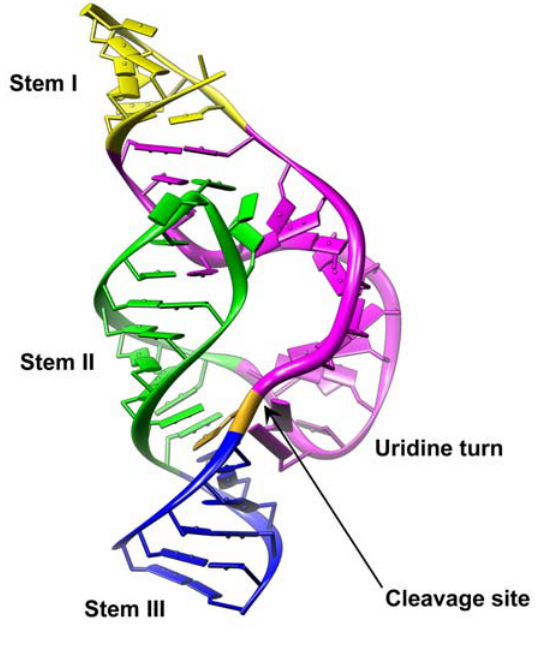
Figure 2. X-ray structure of full-length Schistosoma mansoni hammerhead ribozyme. The ribozyme is coloured according to secondary structure elements and domains (PDB: 2GOZ). The arrow points to the scissile